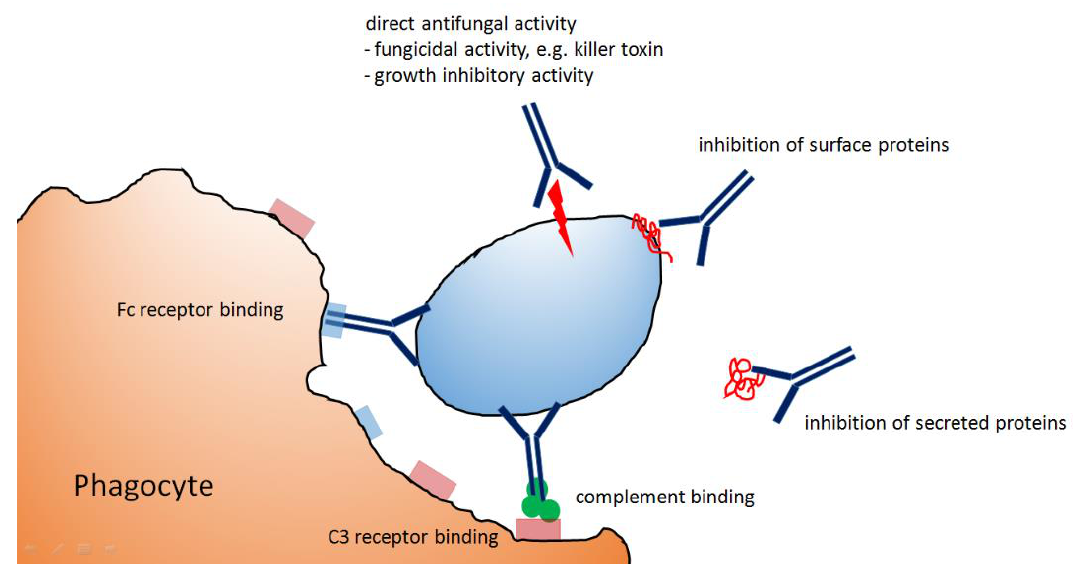
ff erent modes of actions employed by antibodies to inhibit or kill fungal Figure 1. Different modes of actions employed by antibodies to inhibit or kill fungal pathogens. Figure 1. Di